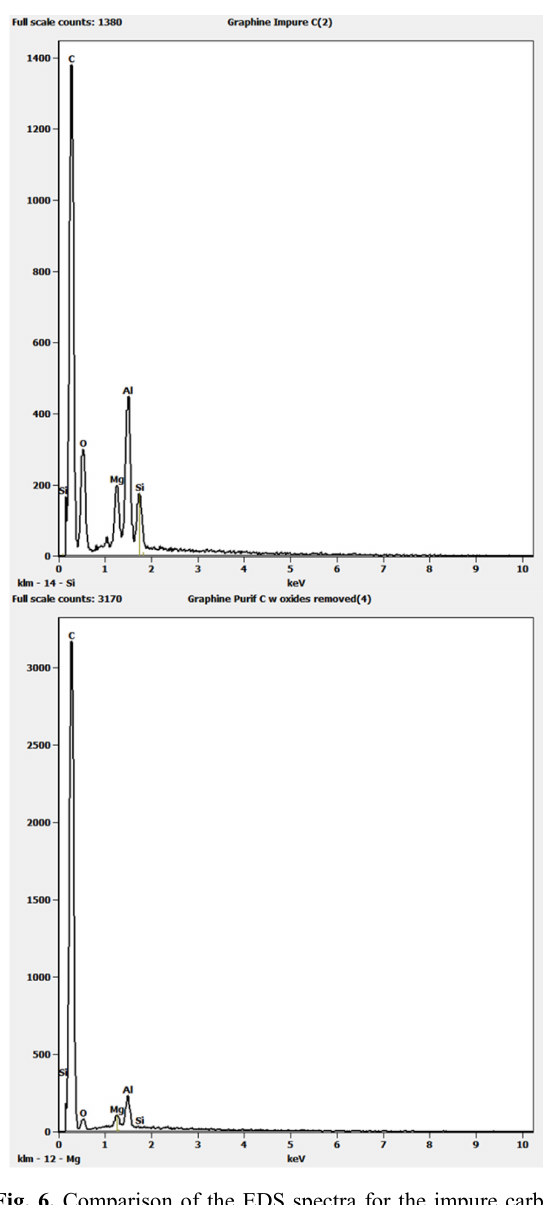
Fig. 6. Comparison of the EDS spectra for the impure carbon (top) and purified carbon with the oxide layer removed